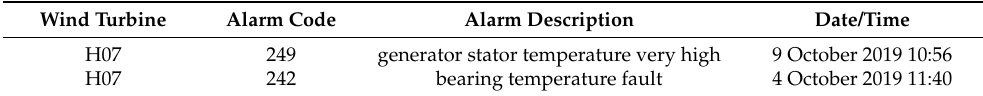
Table 6. Part of the SCADA alarm system corresponding to anomalies for H07.